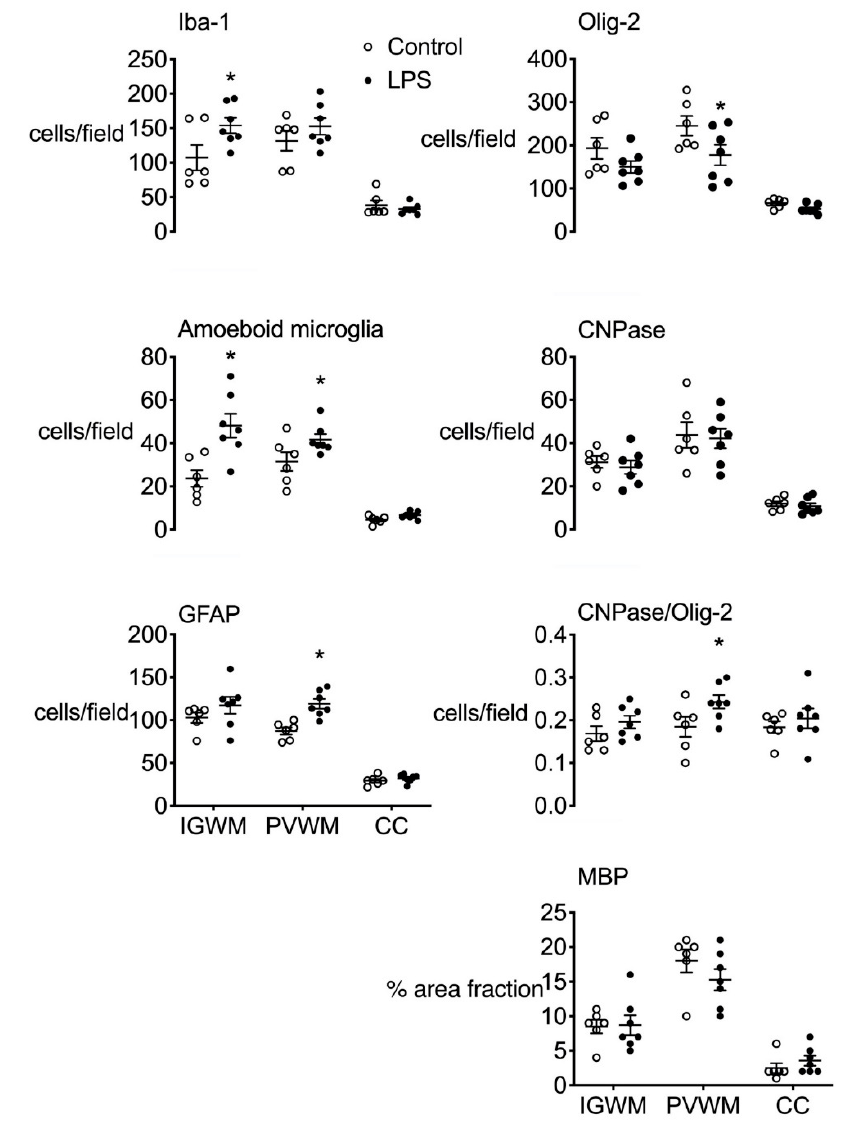
Figure 2. White matter immunohistochemistry. Ionized calcium-binding adaptor molecule 1 (Iba-1), oligodendrocyte transcriptase factor 2 (Olig-2), amoeboid (Iba-1 positive) microglia, and 2 ′ ,3 ′ -cyclic-nucleotide 3 ′ -phosphodiesterase (CNPase)-positive cell counts, the proportion of mature CNPase oligodendrocytes (CNPase / Olig-2 positive cells) and the percentage area of myelin basic protein (MBP)-positive staining in the intragyral and periventricular white matter tracts (IGWM and PVWM, respectively) and corpus callosum (CC) in control (open bars, n = 6) and LPS groups (closed bars, n = 7). Data are means ± SEM. LPS, lipopolysaccharide, * p < 0.05, LPS vs. control.